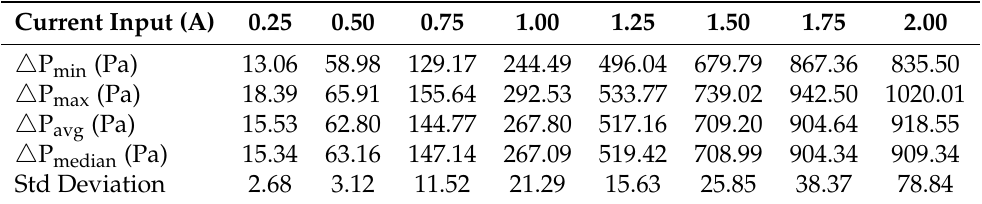
Figure 9. A box plot of MRFs pressure (Pascal) and input current (Ampere). Table 1. Experiment